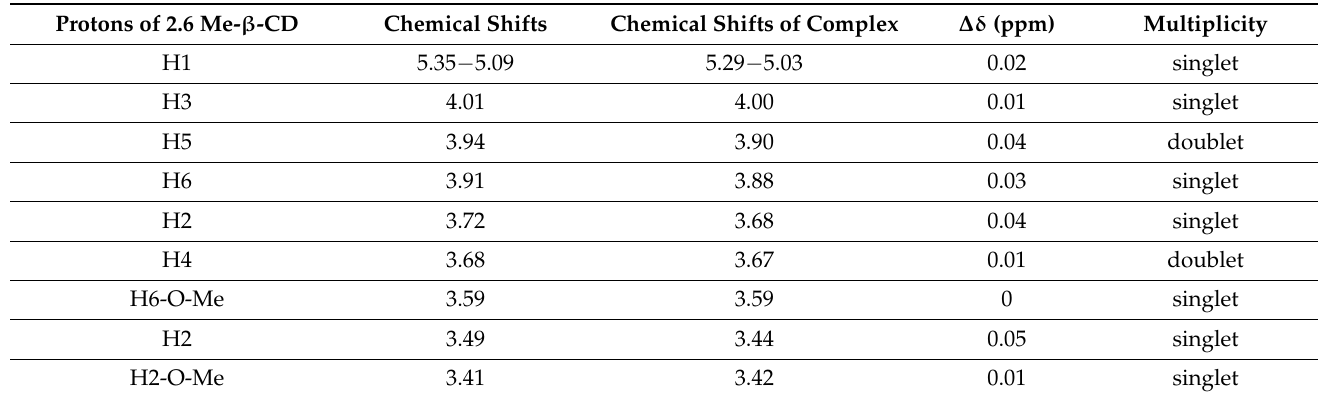
Figure 3. The 1 H NMR of ( A ) 2HP- β -CD ( B ) complex of QUE with 2HP- β -CD. The spectra were obtained at 25 °C in D 2 O. Table 3. 1 H NMR chemical shifts for 2HP- β -CD and the lyophilized complex, in D 2 O at 25 °C.